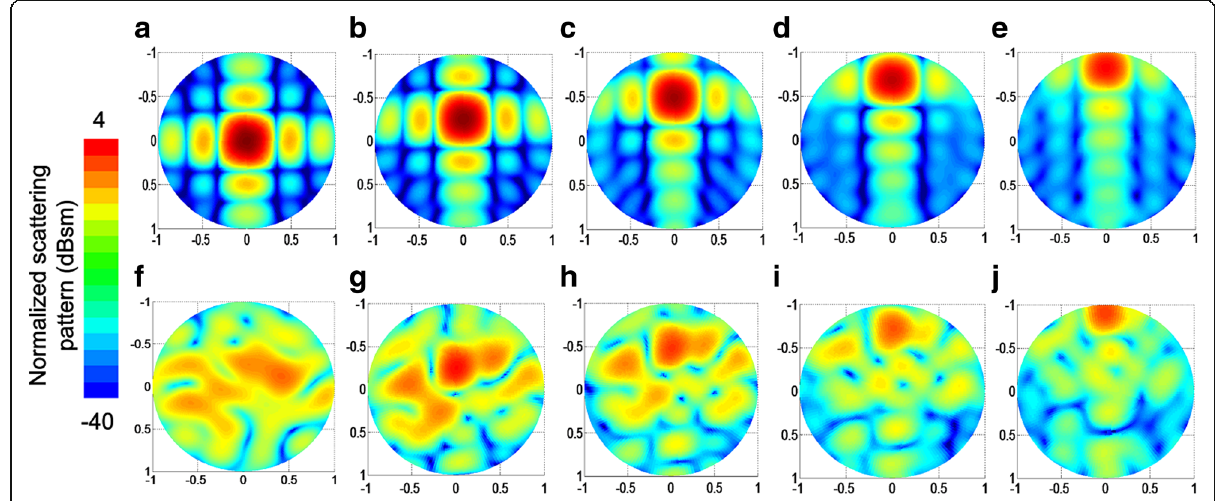
Fig. 11 Normalized scattering patterns under oblique incidence at 6 GHz. a – e Scattering patterns of metal board with an incident angle of 0° ( a ),